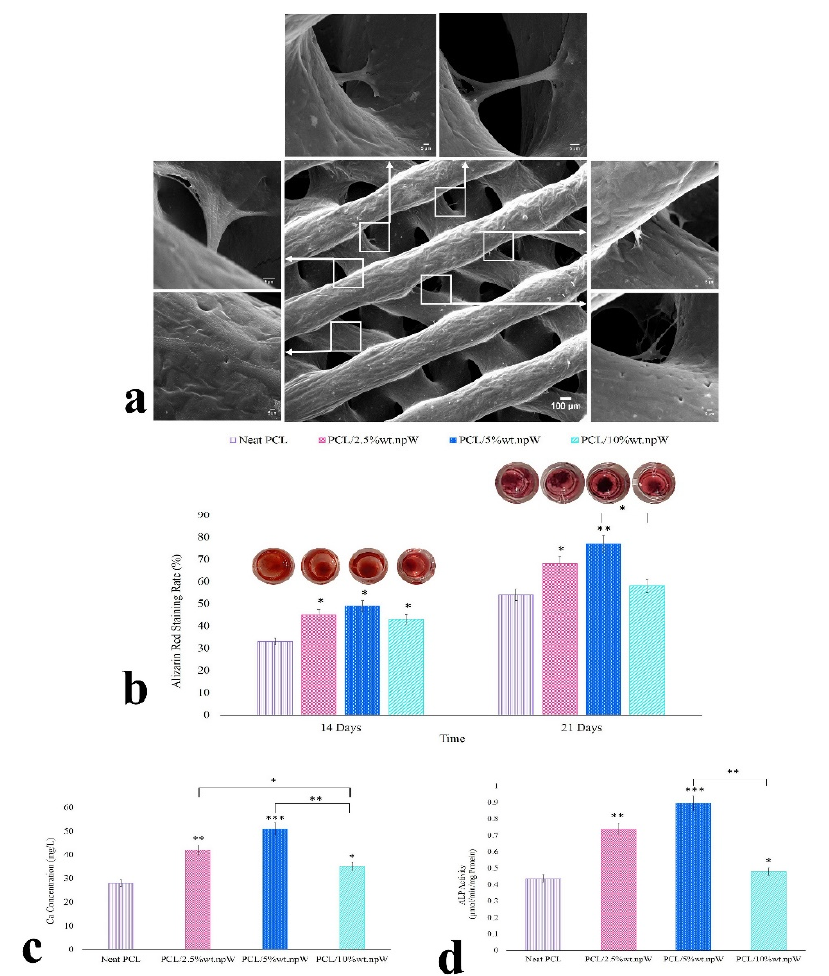
Figure 5. Morphology and differentiation of the rBMSCs in the 3D scaffolds. ( a ) The cell morphology and spreading of rBMSCs cultured on PCL/5% wt. npW. at 7 days post-seeding. ( b ) The photograph of calcium mineral deposits and the amount of calcium deposits were analyzed by Alizarin Red staining assay. ( c ) The quantitative analysis of calcium concentration after 21 days culture under osteogenic medium conditions. ( d ) ALP (Alkaline phosphatase) activity was the quantified concen- tration after 14 days in culture under osteogenic medium conditions, such as µ mol of p-nitrophenol phosphate produced per min and mg protein. Data are shown as mean ± SD. * p < 0.05, ** p < 0.01, *** p < 0.001 compared to neat PCL.